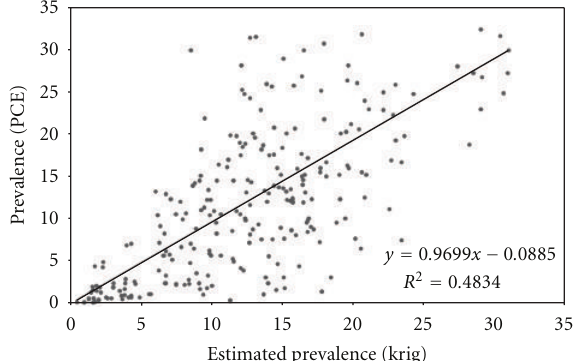
Figure 4: PCE- and kriging-estimated prevalences for 255 munici-